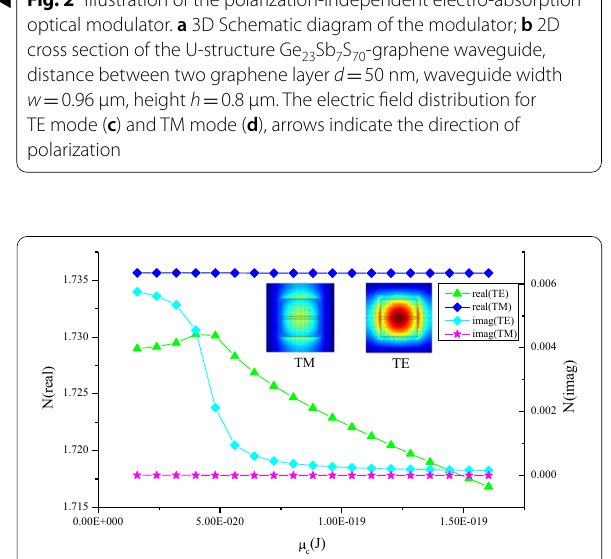
Fig. 3 Graphene was straightly paved in Ge 23 Sb 7 S 70 strip waveguide. The real and imaginary parts of EMI for both TE and TM modes at the wavelength of 2.2